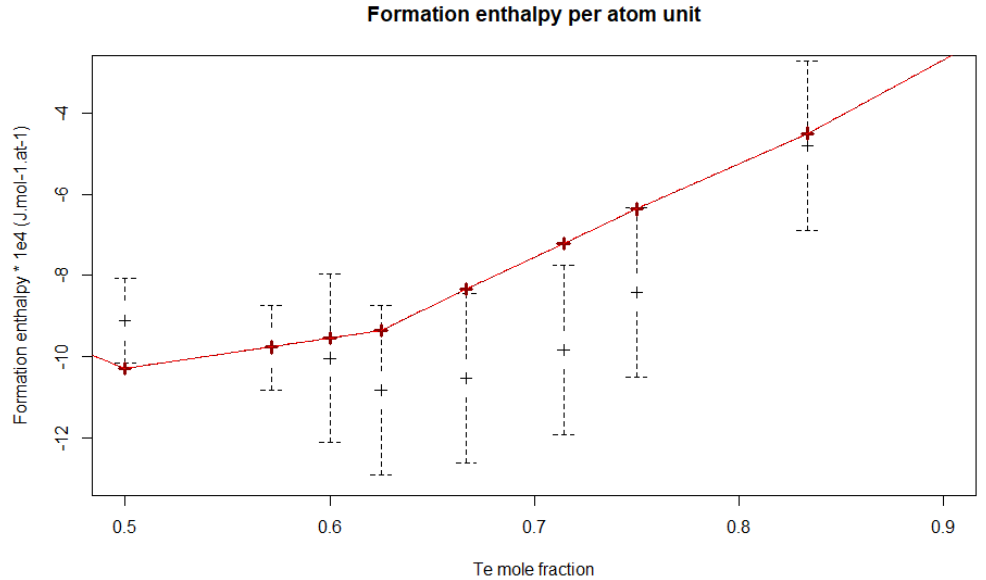
Figure 9. Uncertainty estimation given by the 95% credible interval of the posterior probability distribution for the calculated enthalpies of formation for UTe, U 3 Te 4 , U 2 Te 3 , U 3 Te 5 , UTe 2 , U 2 Te 5 , UTe 3 , and UTe 5 . The experimental error bars are in dotted black lines. The propagated uncertainties (95% credible interval) for each computed quantity are in bold red